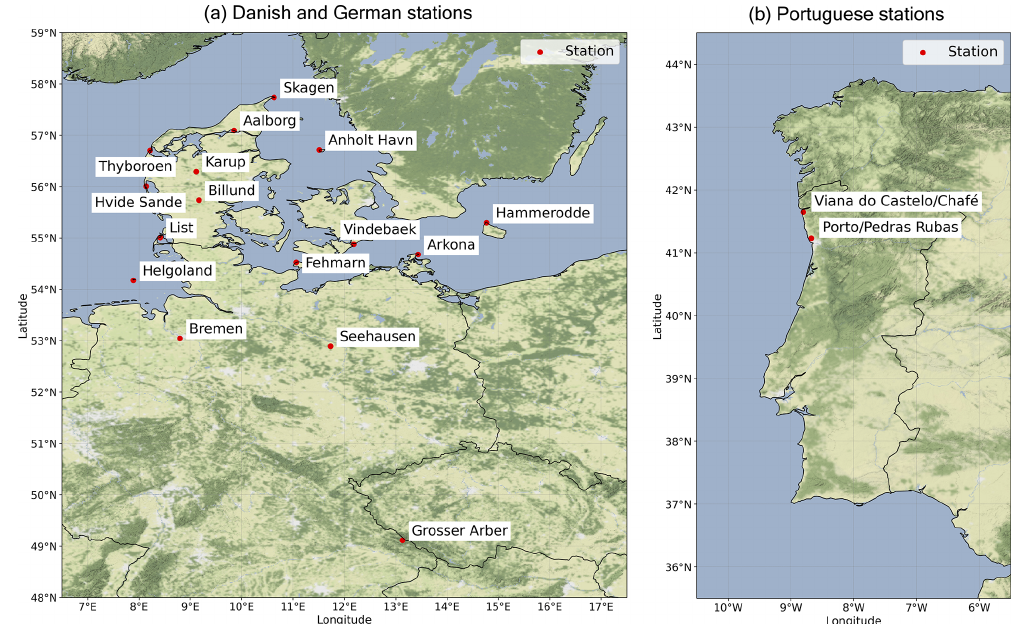
Figure 1. Locations of the 18 meteorological stations investigated. (a) Danish and German stations; (b) Portuguese stations (© Stamen